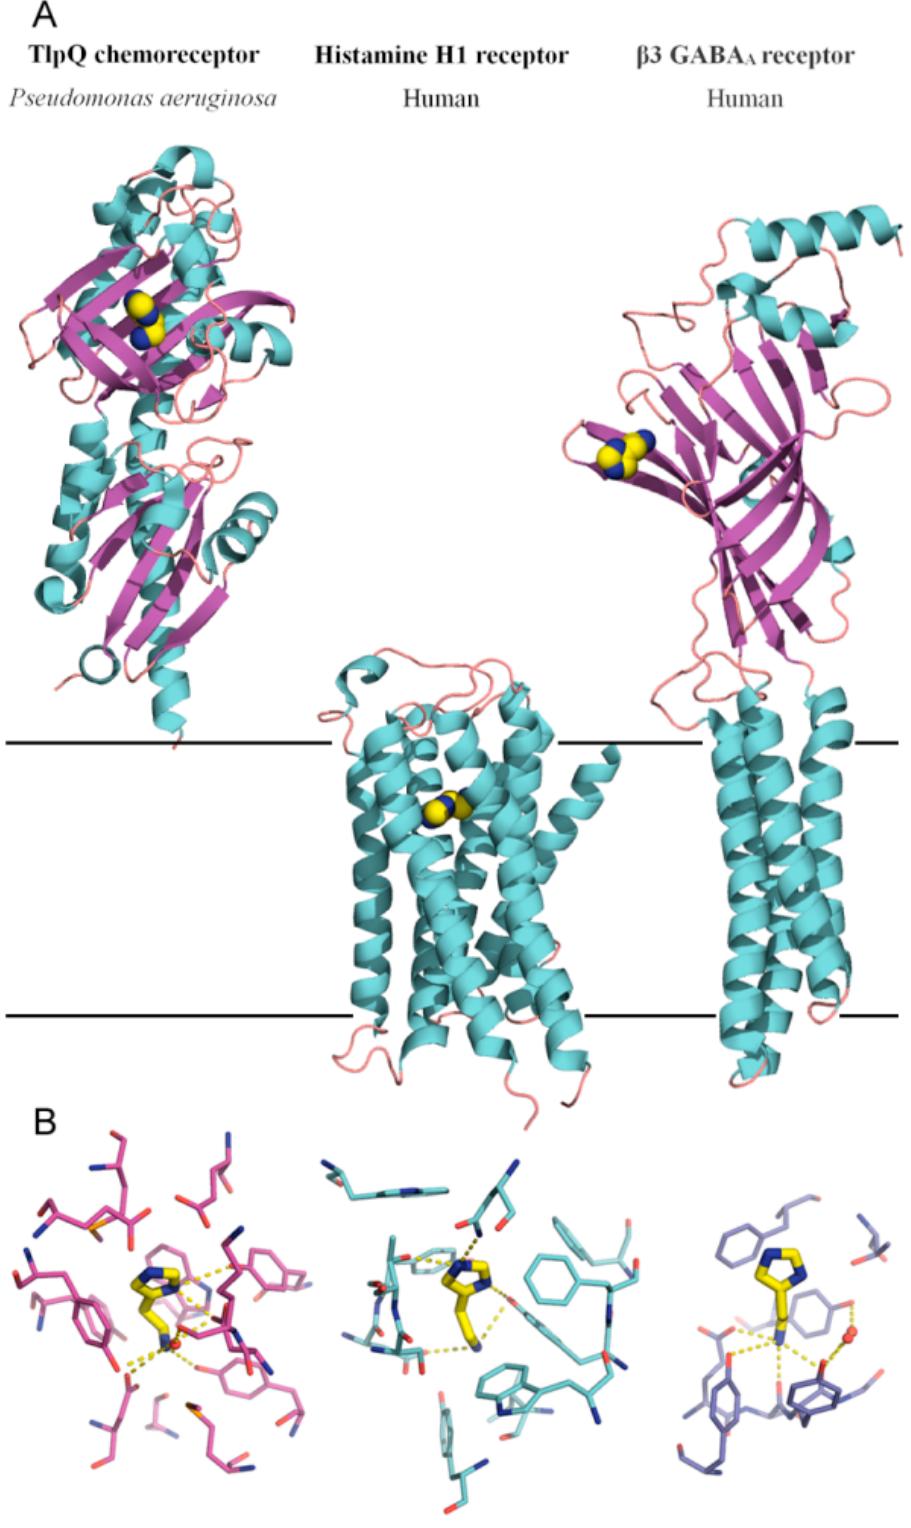
Figure 2. Bacterial and human histamine receptors. ( A ) Shown is the ligand-binding domain of the TlpQ chemoreceptor from P. aeruginosa PAO1 (PDB ID 6FU4), the human histamine H1 receptor (PDB ID 7DFL) and the human β 3 GABA A receptor (PDB ID 7A5V). Bound histamine is shown in stick mode in the lower part of the figure. These structures have been published in [23,69,70]. ( B ) Zoom on the histamine binding sites of the receptors shown